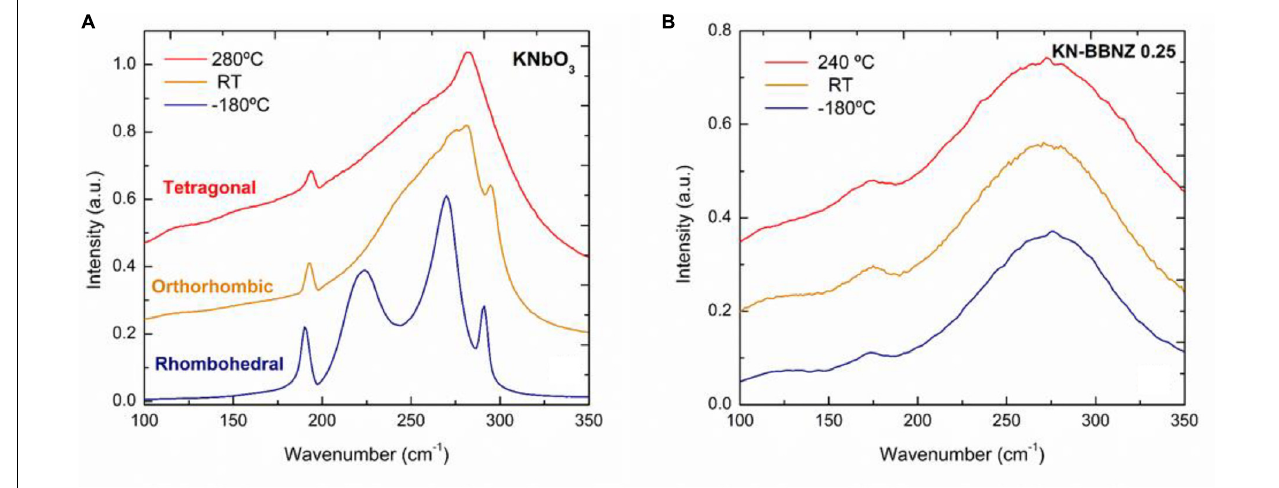
FIGURE 6 | In situ Raman spectroscopy for (A) undoped KN and (B) pseudocubic 0.75KN-0.25Ba 0 . 5 Bi 0 . 5 Nb 0 . 5 Zn 0 . 5 O 3 . [Published by The Royal Society of Chemistry, https://doi.org/10.1039/C6TC05515J, https://creativecommons.org/licenses/by/3.0/ (Pascual-Gonzalez et al.,